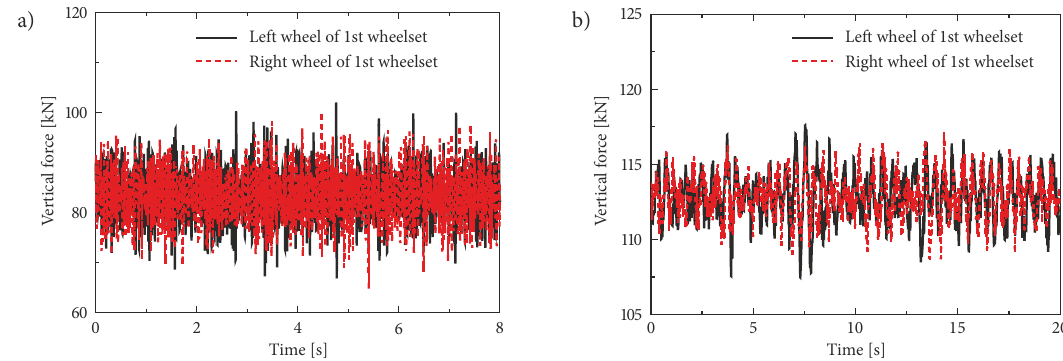
Figure 4. Wheel–rail interaction force: a – high-speed vehicle; b – freight